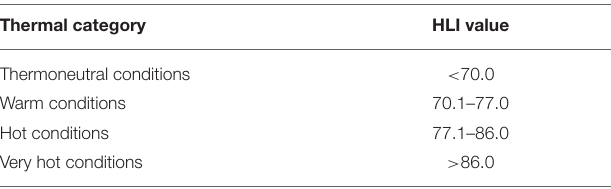
TABLE 3 | Thermal conditions based on heat load index (HLI) values (Gaughan et al.,